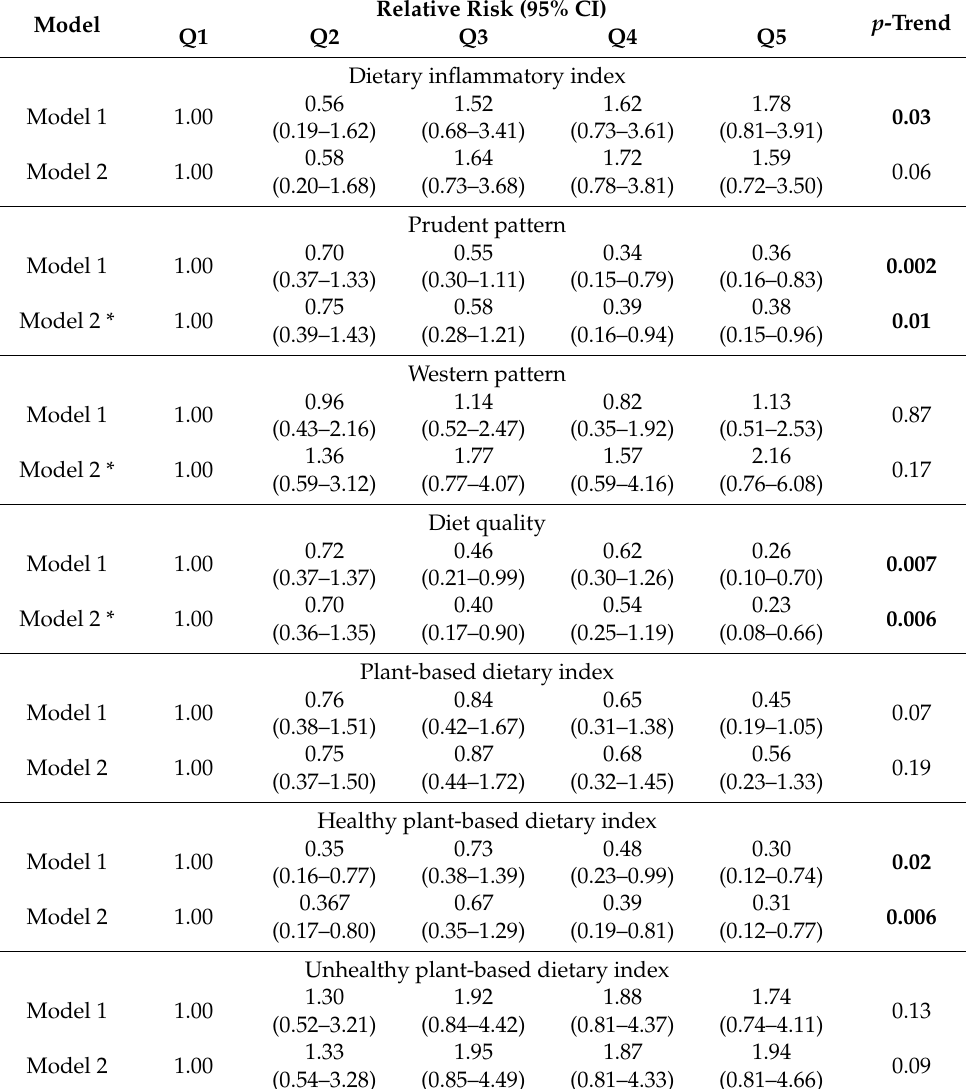
Table 2. Multivariable adjusted models (95% confidence intervals) for the risk of